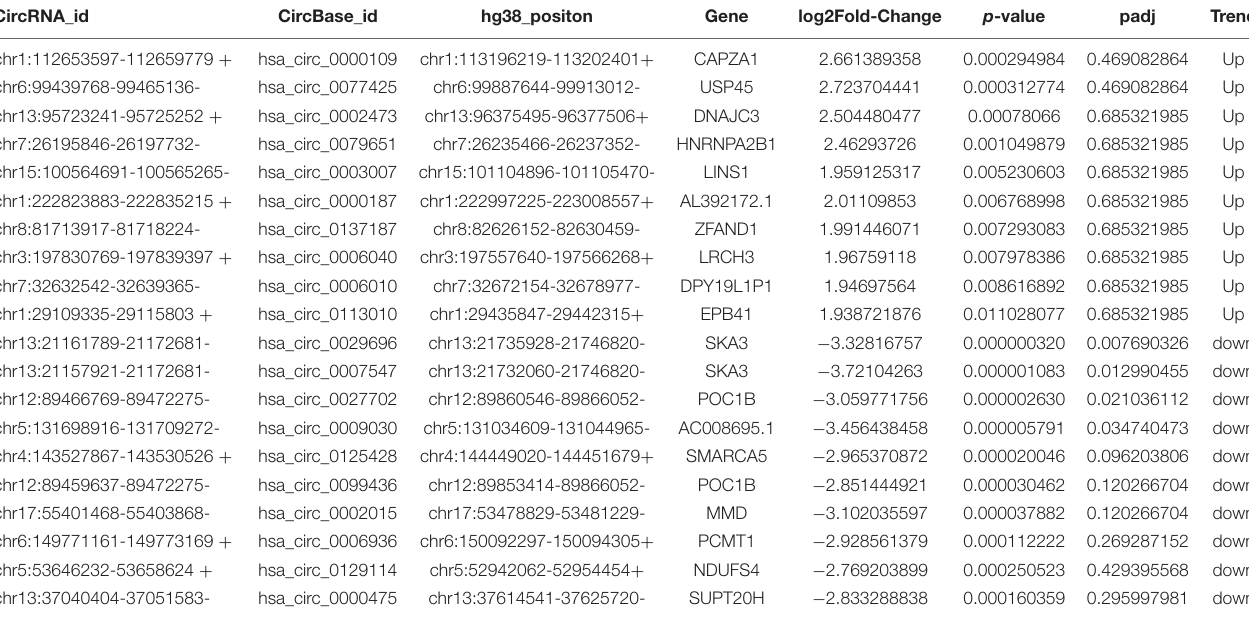
TABLE 2 | Twenty dysregulated circRNAs in whole transcriptome sequencing were